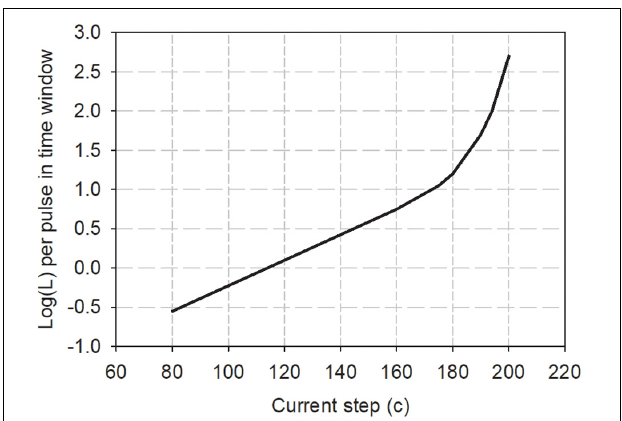
FIGURE 5 | Loudness growth function for one CI user derived from loudness summation experiments as described in the text. To use the Practical Method to estimate the loudness of any electrical pulse train, the loudness contribution of each pulse in 2 ms windows is obtained from the graph and summed to estimate the loudness of the stimulus relative to a reference stimulus of loudness 100 (Data redrawn from McKay et al.,